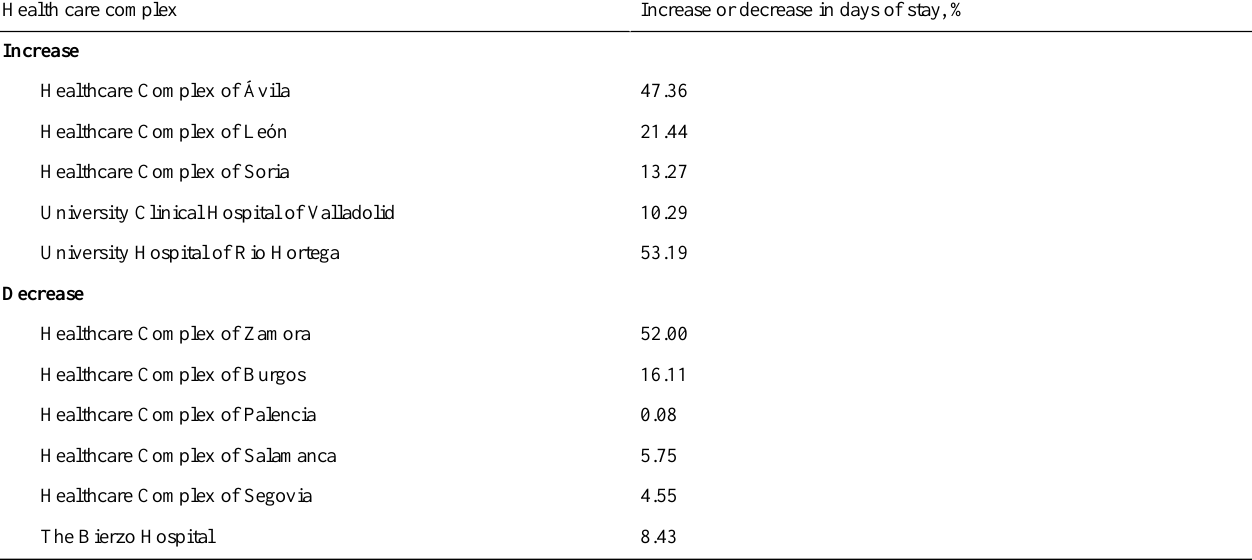
Table 5. Percentage increase and decrease in the number of days of stay in 2012 with respect to the mean days of stay from 2005 to 2011.